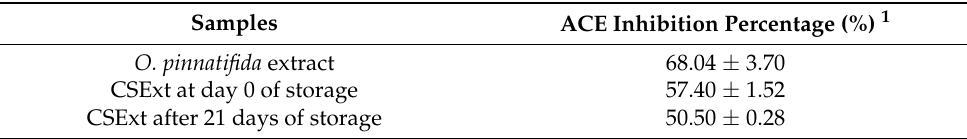
Table 1. Angiotensin I-converting enzyme (ACE) inhibition expressed in terms of the percentage (%) for Osmundea pinnatifida extract and the cheese spread incorporating O. pinnatifida extract (CSExt) at day 0 and after 21 days of storage.